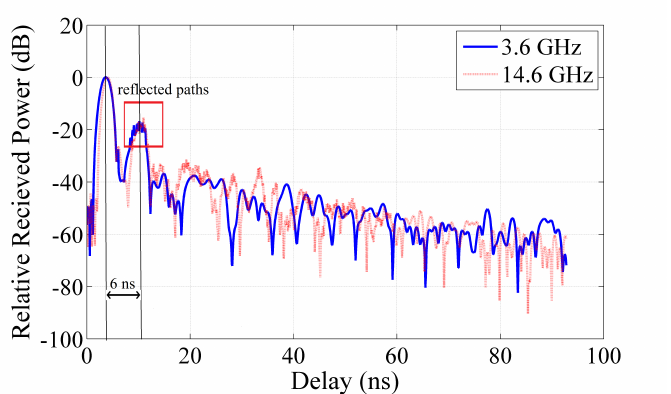
Figure 5. (color online) Normalized APDPs (averaged power delay profile) at 3.6 GHz and 14.6